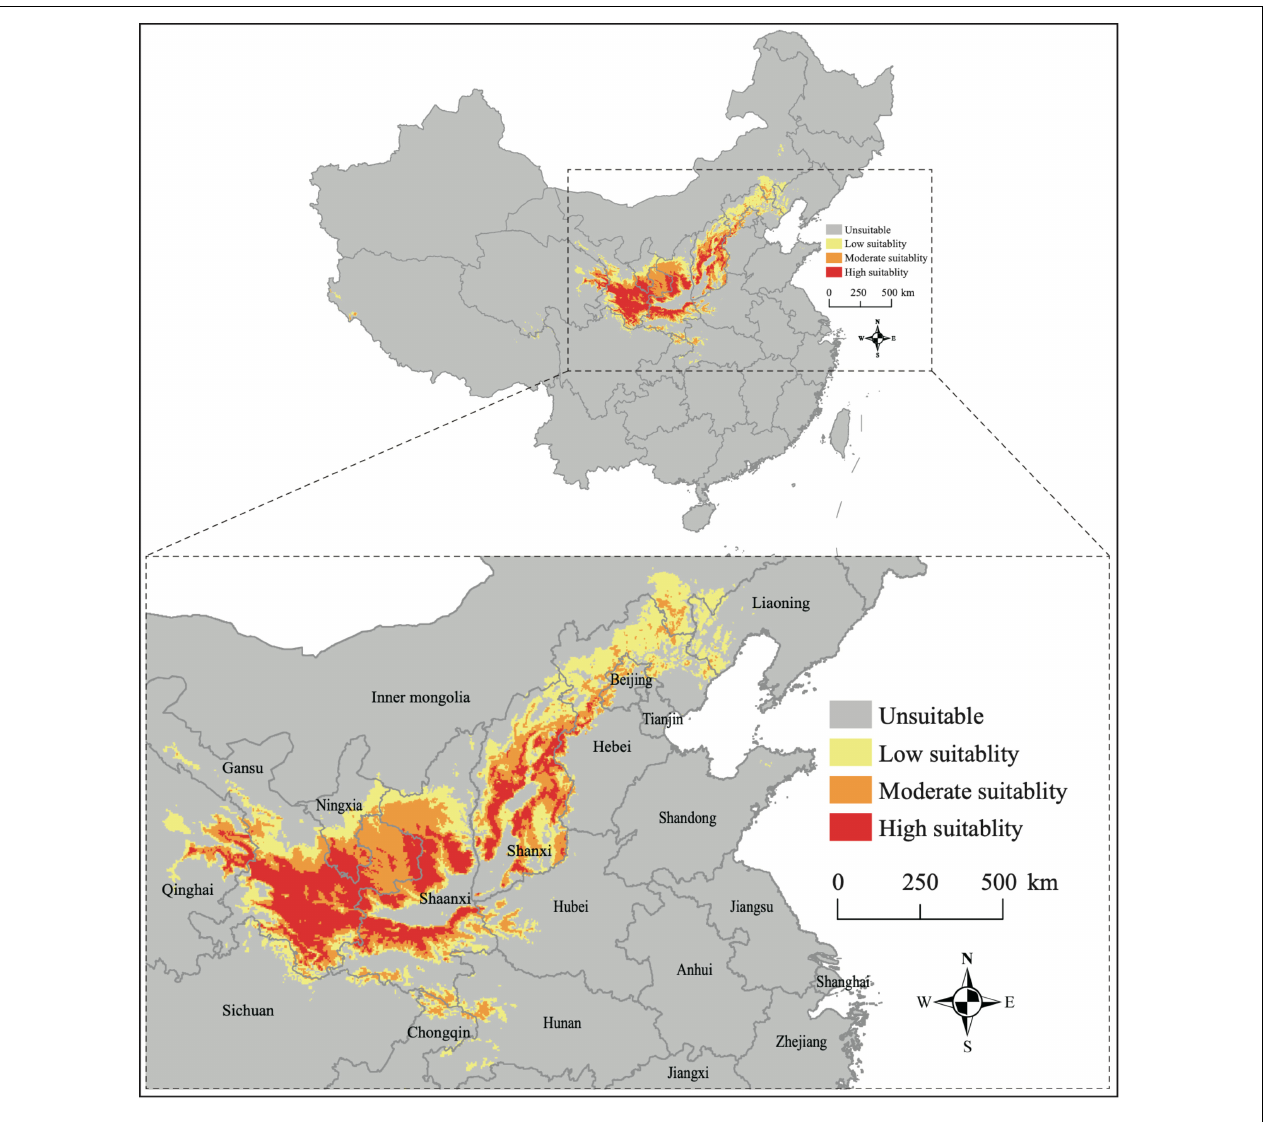
FIGURE 3 | The current potential distribution of B. pyrosoma predicted by MaxEnt based on the values of area under the curve (AUC). Low suitability (AUC = 0.50–0.75), moderate suitability (AUC = 0.75–0.90), high suitability (AUC = 0.90–1.00), and total suitability (AUC =